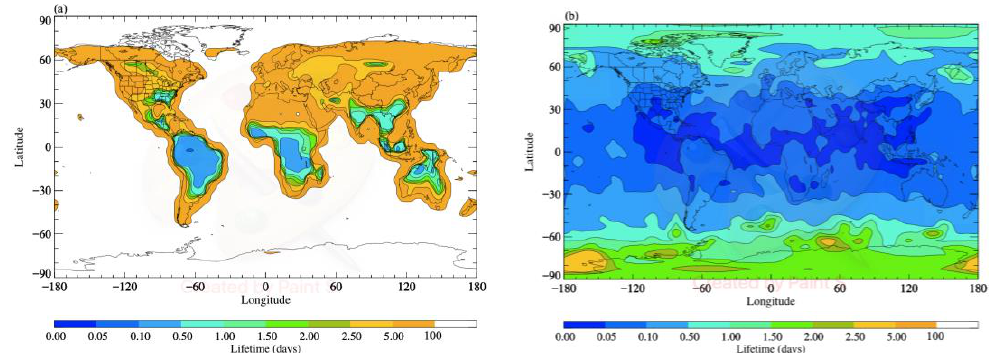
Figure 2. The surface distribution plot depicting the average lifetime of PFOA with respect to reaction with ( a ) SCIs, ( b ) SCIs and OH in days. Areas in white represent positions where the lifetime of PFOA is expected to be greater than 100 days.